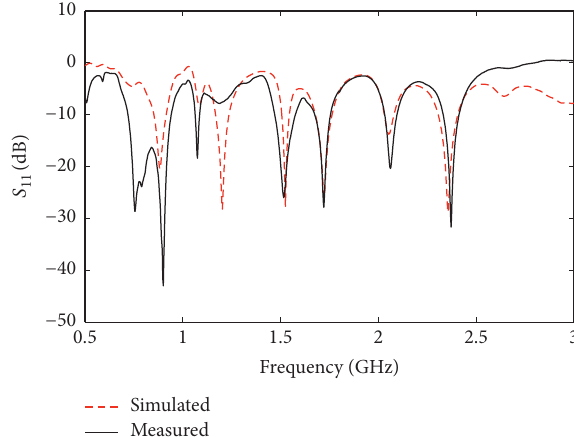
Figure 11: Simulated and measured S